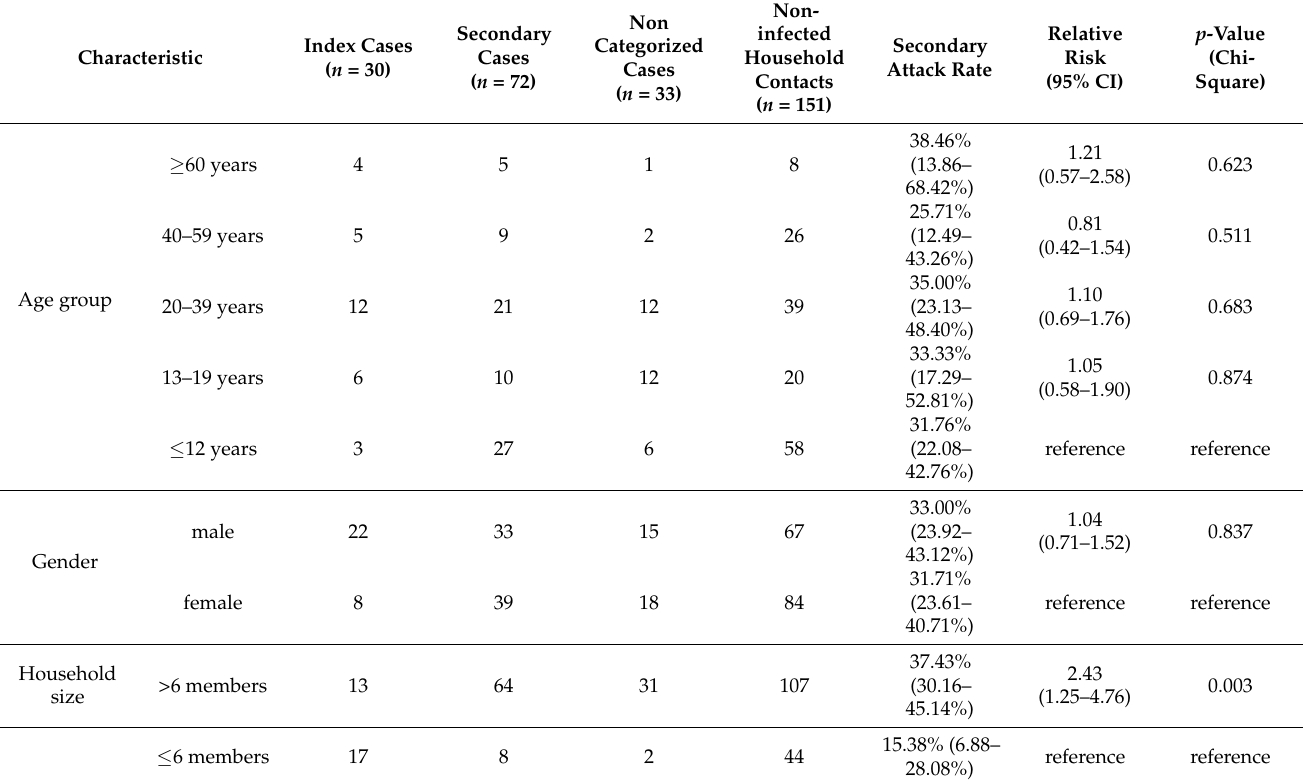
Table 2. Within-household secondary attack rates and distribution of cases according to demographic characteristics.